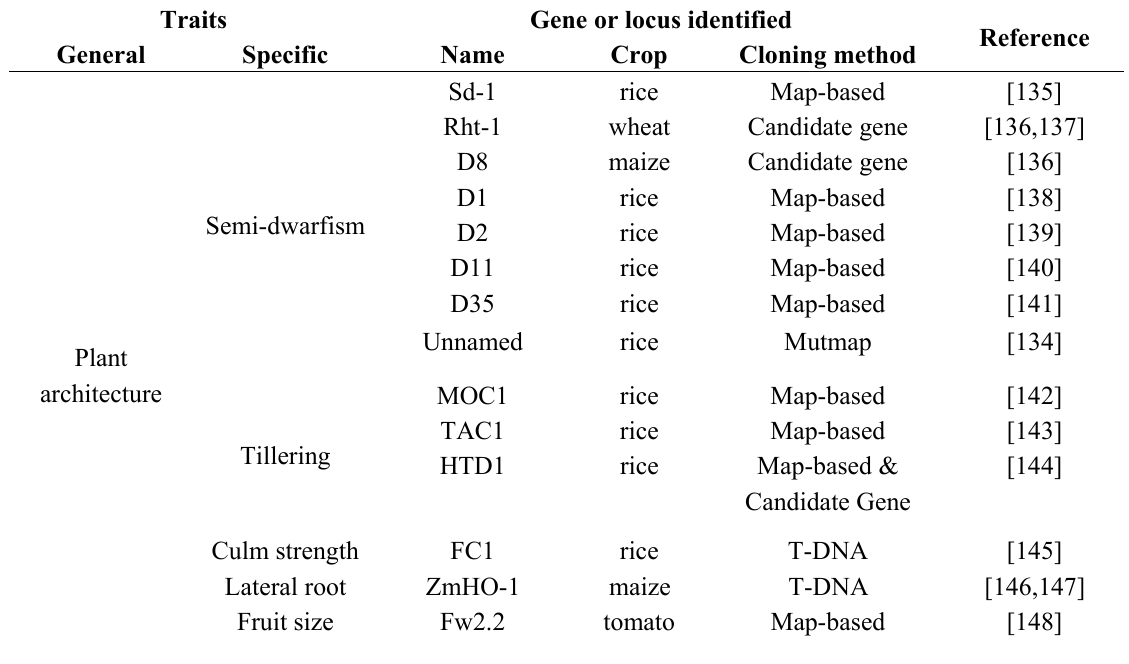
Table 2. Partial list of agriculturally important traits and method of isolation in major